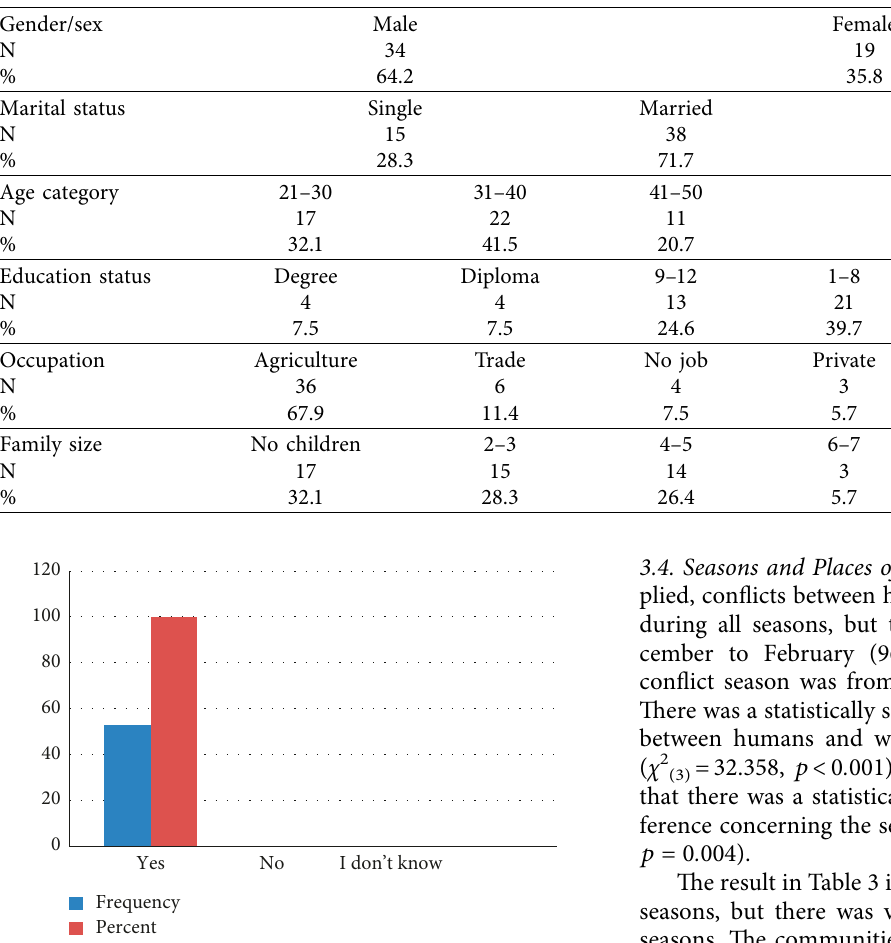
Table 1: Demographic characteristics of study participants.